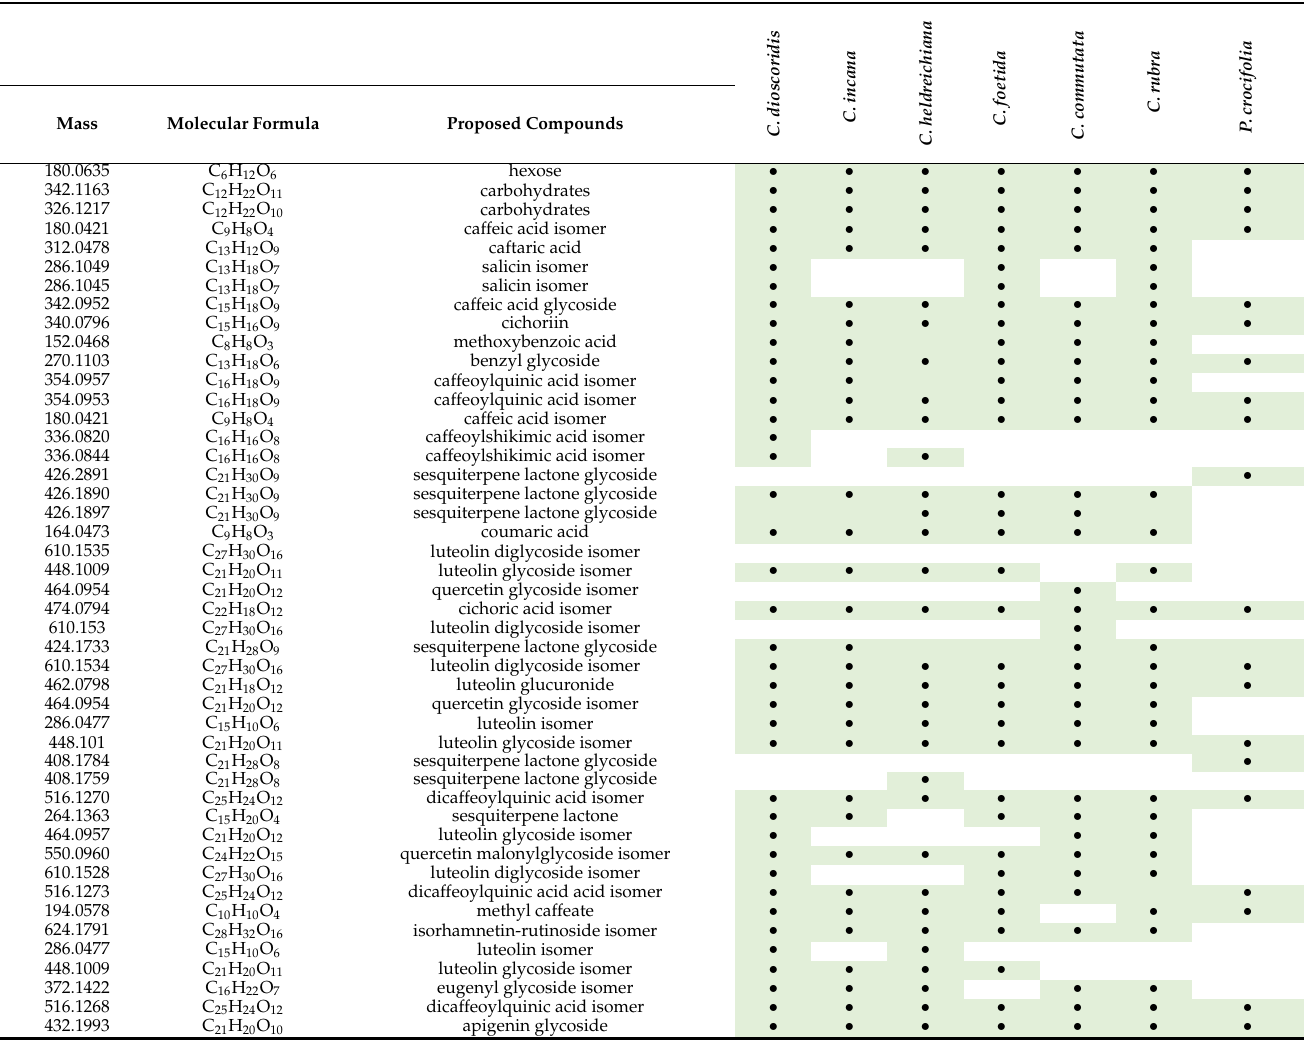
Table 1. LC-MS analyses on Crepis